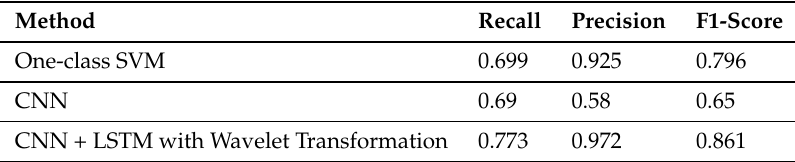
Table 2. Results of Testing Our Supervised Classification